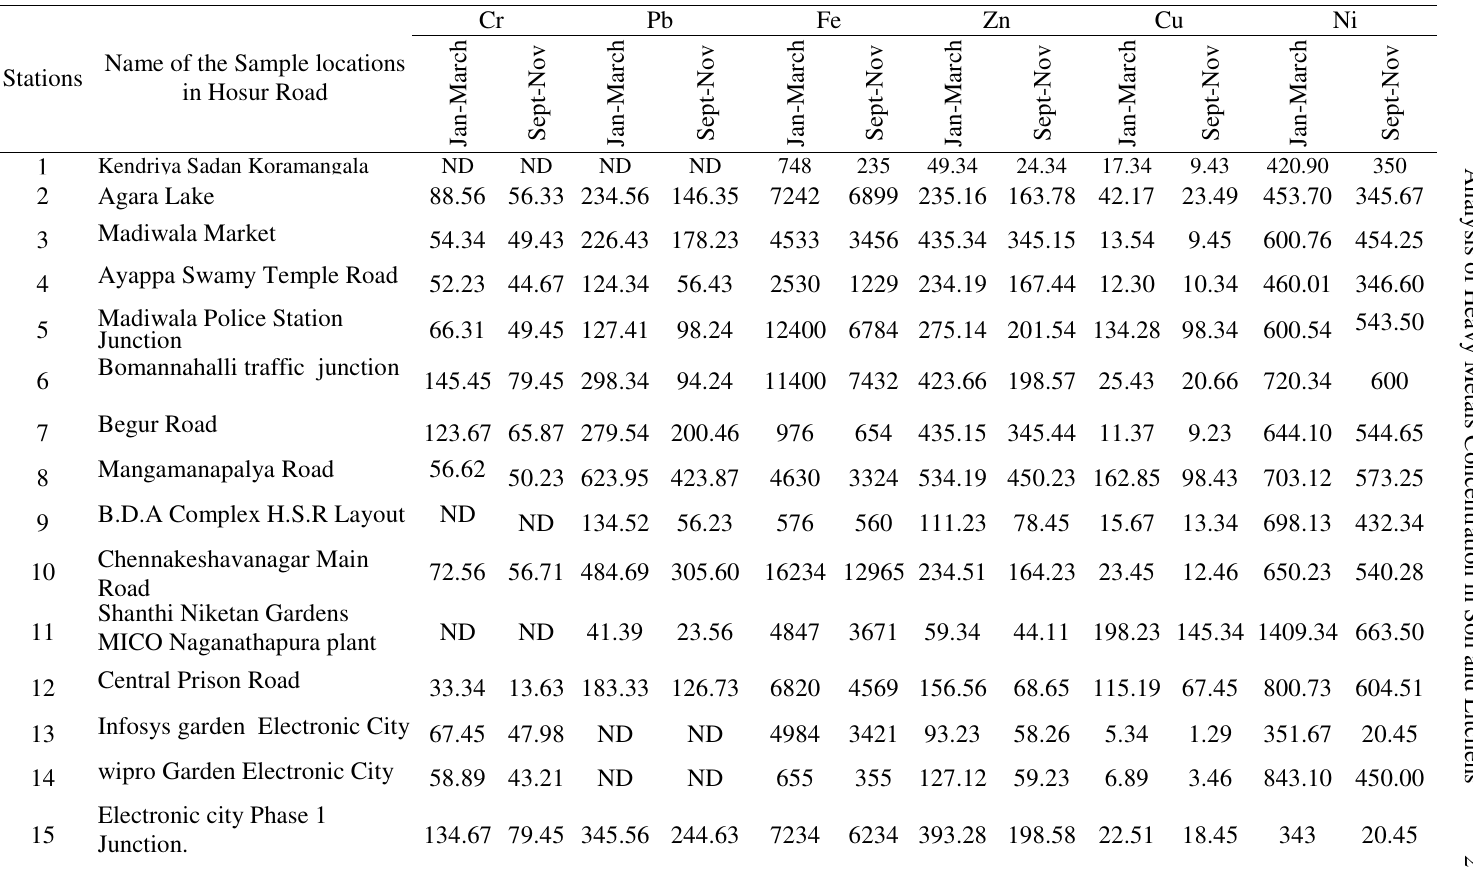
Table 4. Heavy metal concentrations / µ g g –1 dry weight in soils of Hosur Road, Bangalore South. Cr Pb Fe Zn Cu